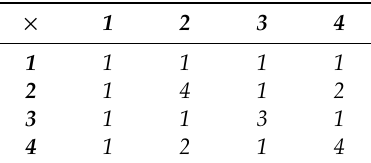
Table 12. The operation × on